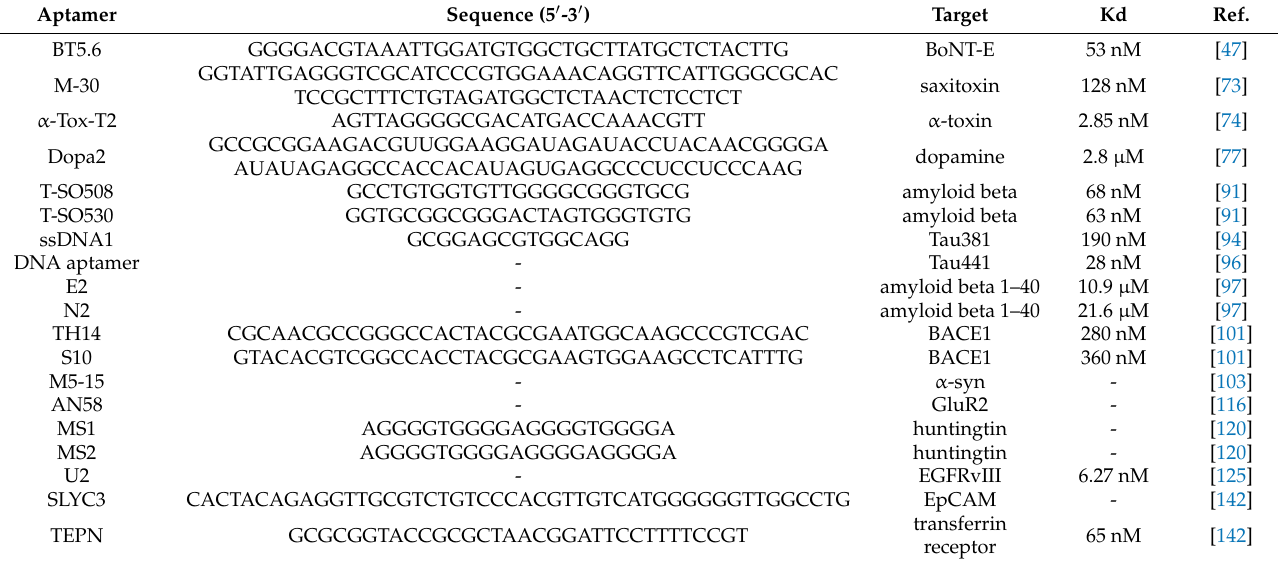
Table 3. Aptamers used in neuroscience